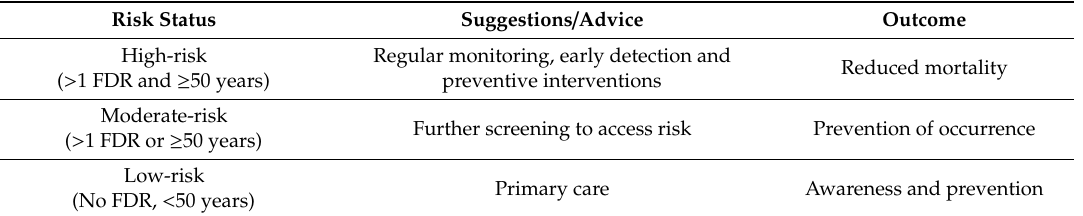
Table 3. Summarized recommended guidelines for the management of breast cancer risk screened by the simple model in the women of North